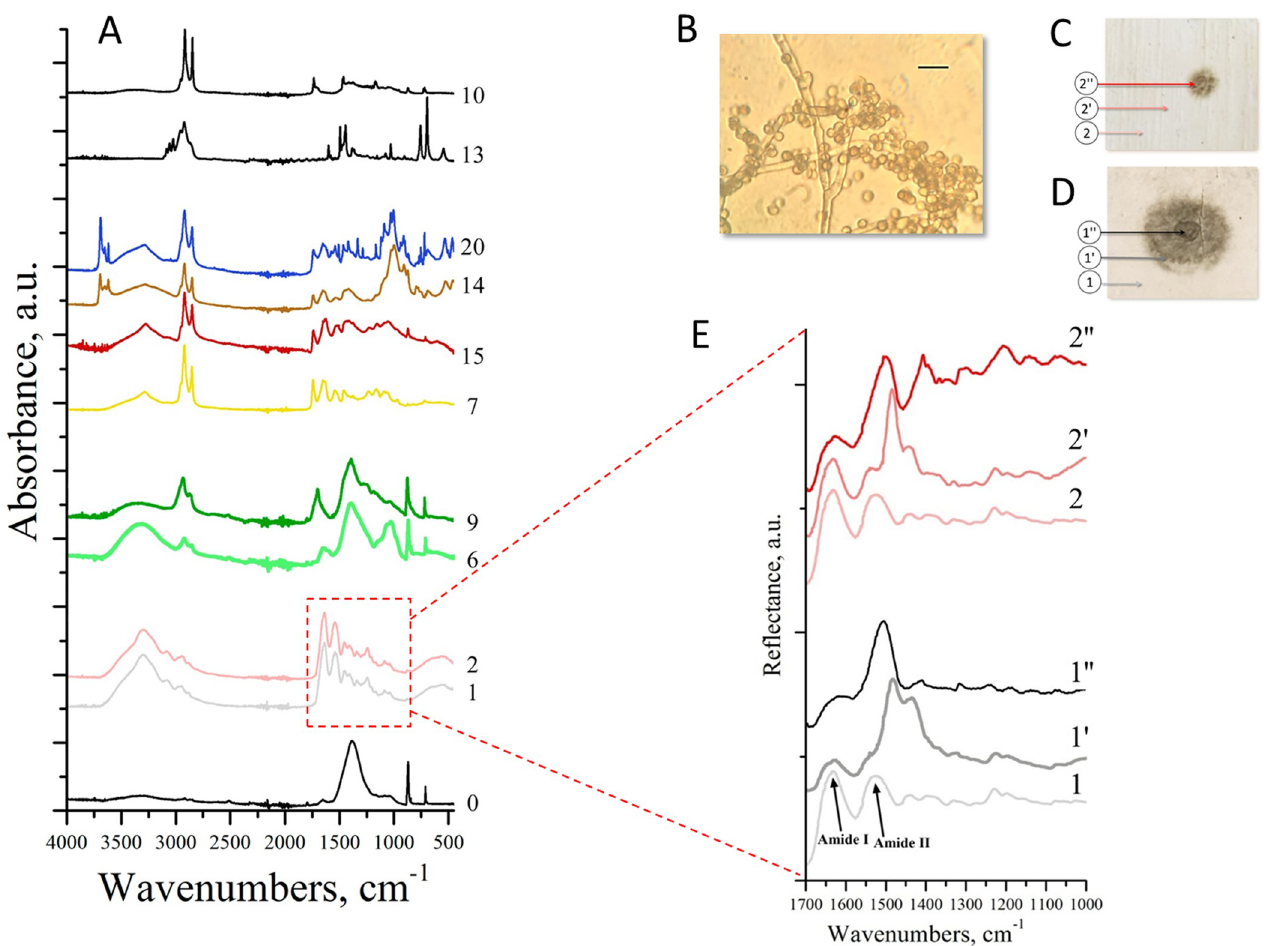
Fig 2. Characterization of mock layer models using micro-FTIR spectroscopy. (A) FTIR absorption spectra for intact mock layers. (B)–(E) Modeling of sturgeon glue biodeterioration with cultured isolate 93B (containing C . parahalotolerans ). Light microscopy analysis of inoculum 93B; scale bar = 10 μ m (B). Spectral properties of sampling zones: 1, 2 –intact zones; 1’, 2’–periphery of the inoculated zone (according to the growth on mock layer 1); 1’’, 2’’–center of the inoculated zone (C–E). Visible biodeterioration of mock layers 1, 2 with inoculum 93B after 12 days at 25˚C (C, D). FTIR spectra revealing biodeterioration (E). Levkas, 0; glues: 1, 2 –sturgeon glue without and with 1% SPCP, respectively; plasticizers: 6 –gum arabic, 9 –rosin; tempera paints: 7 –egg emulsion, 14 –egg tempera with ochre, 15 –egg tempera with cinnabar, 20 –egg manufacturing tempera “Rowney” (Monestial Blue Phthalo); varnishes: 10 –wax-oil mastic, 13 – Dammar varnish (see also S1 Table). Colors of spectra for tempera mock layers (7, 14, 15, and 20) correspond to those of the layers.